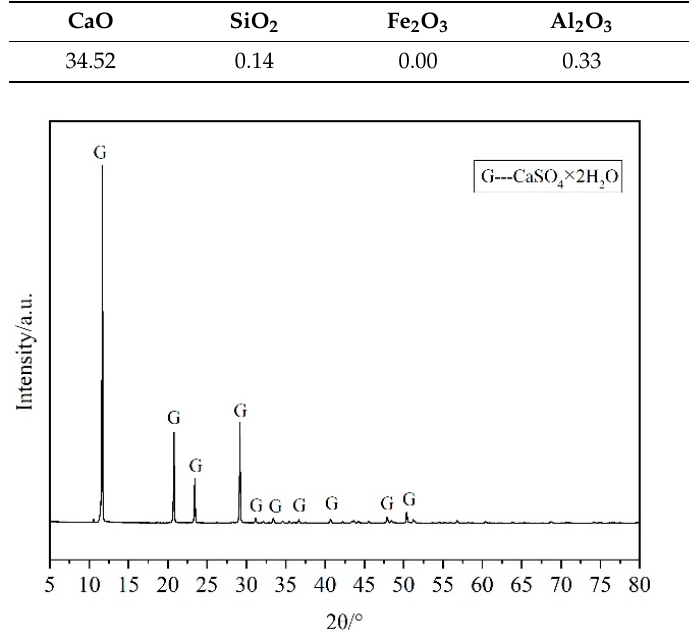
Figure 3. XRD pattern of gypsum.